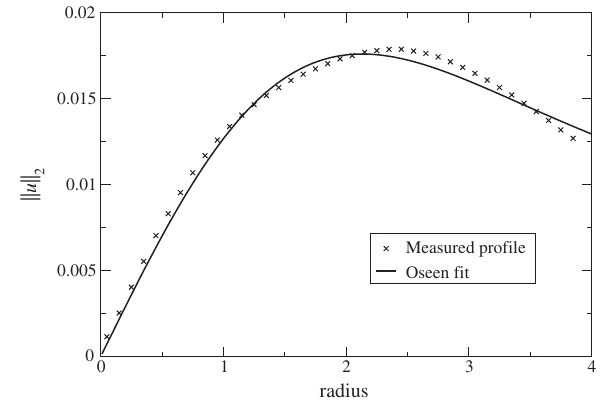
FIG. 7. Velocity profile of one of the vortices in Fig. 1(f). The solid line is the fit to the Oseen vortex